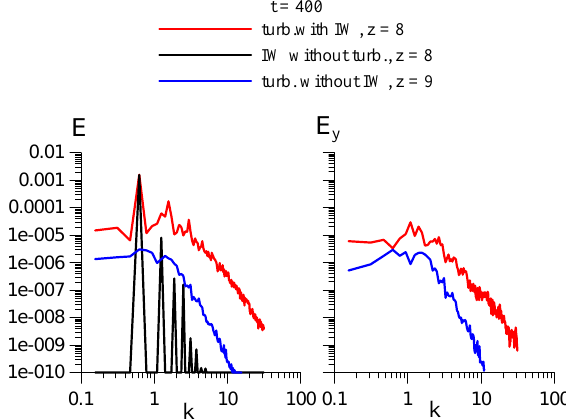
Figure 7. The kinetic energy power spectrum, E(k) (left), and the spectrum of the y -velocity component, E y (k) (right), obtained in DNS with initially excited IWs at the pycnocline center level ( z = 8) at time t = 400. The kinetic energy spectrum of the internal wave in the absence of a turbulent layer and spectra E and E y of turbulence without an initially induced IW obtained at the level of maximum kinetic energy ( z = 9) at time t = 400 are also provided for compar-